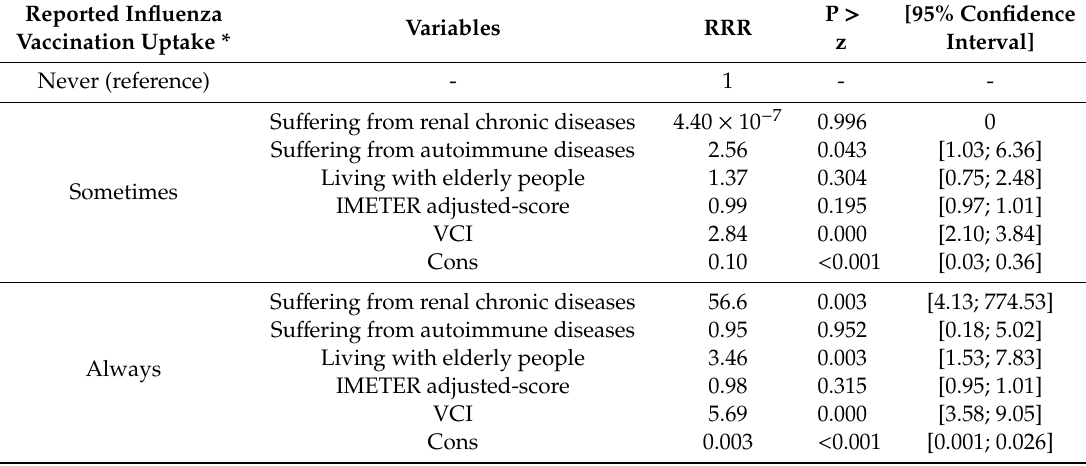
Table 4. Multinomial logistic regression model. Dependent variable: reported influenza vaccination uptake and intention to vaccinate (three levels: “never get vaccinated”, “sometimes get vaccinated”, “always get vaccinated). The reference category of the dependent variable was “never get vaccinated”. Relative risk ratio (RRR) values were adjusted by sex, age, and mother